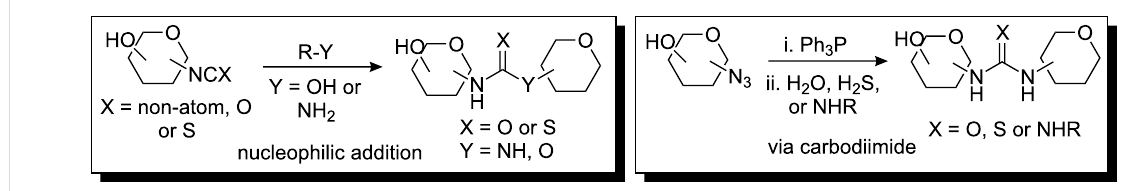
Figure 14: Approaches to access pseudoamide-type oligosaccharide mimics.